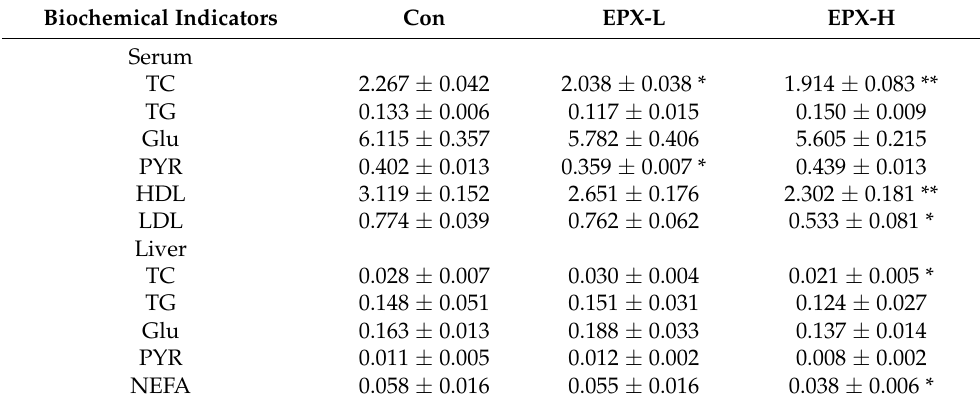
Table 1. Effects of EPX exposure on the biochemical indicators of mice.